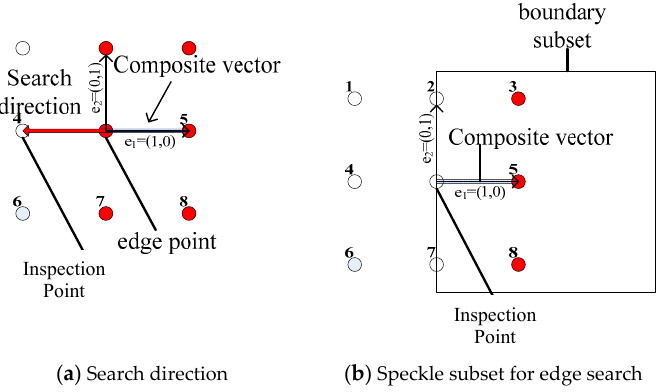
Figure 11. Boundary subset for horizontal or vertical edge search.